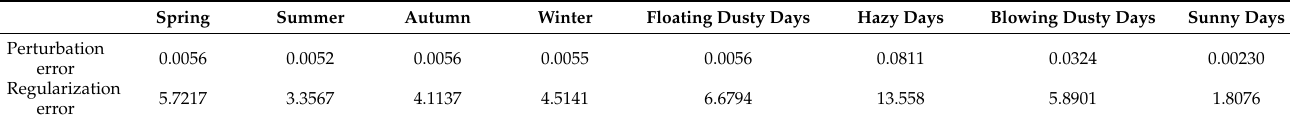
Table 3. The perturbation error and regularization error of Tikhonov regularization algorithm inversion under different seasons and weather